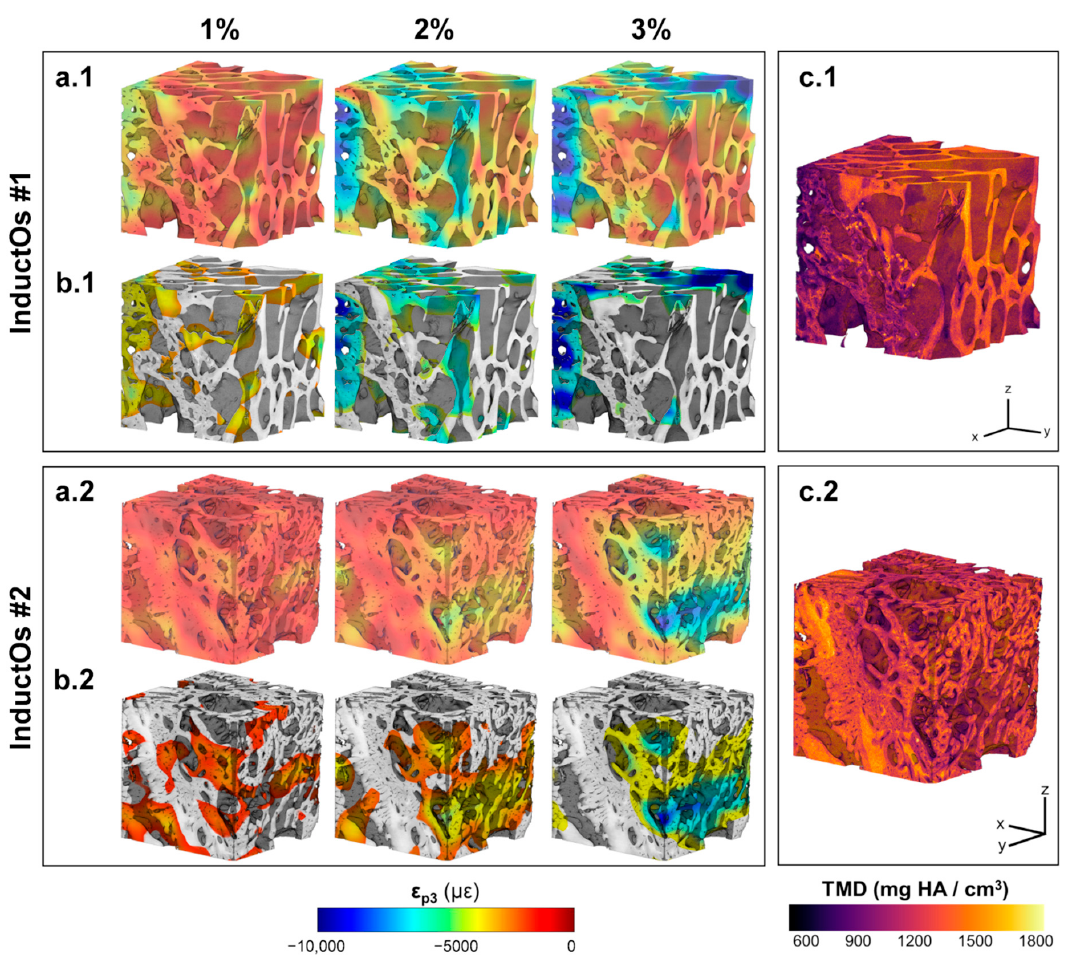
Figure 6. ( a )( a.1 , a.2 ) 3D full-field third principal strain distribution ( ε p3 ) at each compression step for the VOI of InductOs specimens, and ( b )( b.1 , b.2 ) corresponding 20% of the bone volume fraction (BV / TV) that was highly strained. An increase and redistribution in the accumulated strain was observed after consecutive compression steps. ( c )( c.1 , c.2 ) Tissue mineral density (TMD) distribution in the VOI of each specimen. The more remodeled trabeculae showed higher mineralization compared to the newly formed bone tissue in InductOs #1. Highly mineralized areas were identified in the woven bone for InductOs #2.